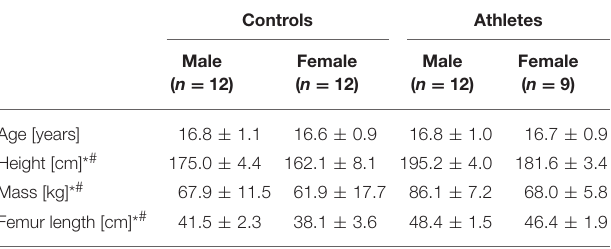
TABLE 2 | Knee joint moments and antagonistic coactivation of adolescent controls and volleyball athletes.